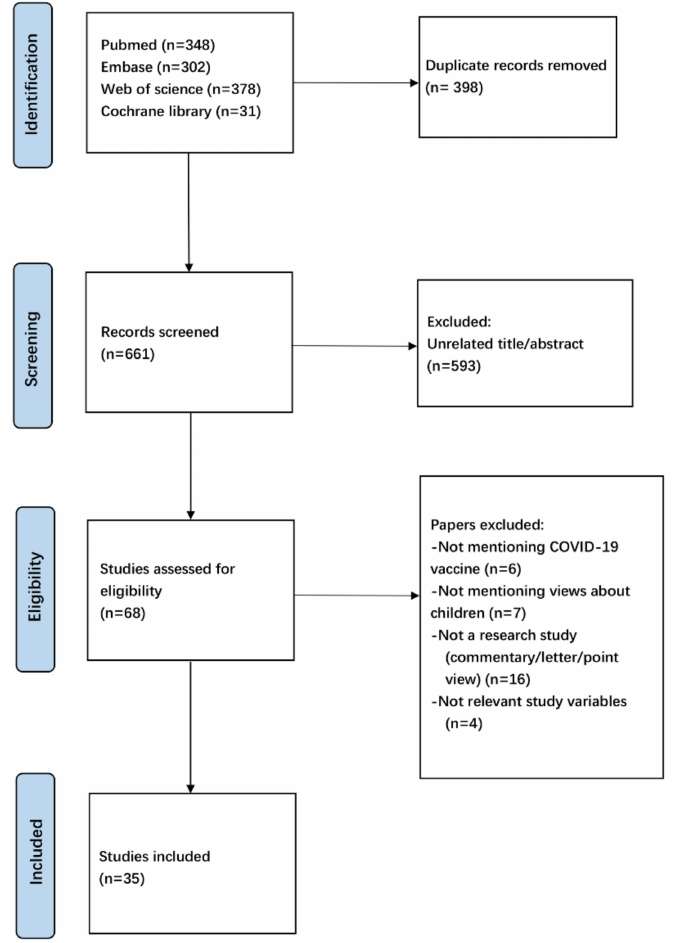
Figure 1. PRISMA flow diagram of study